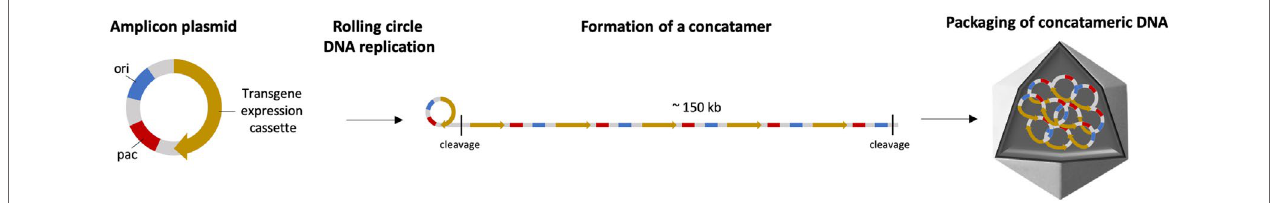
FIGURE 2 | Schematic representation of an amplicon vector. The amplicon plasmid contains the sequences for viral DNA replication (ori, blue) and the packaging signal (pac, red), flanking the transgene expression cassette. In the presence of an HSV-1 helper virus in permissive cells, the amplicon DNA plasmid is replicated as head-to-tail concatemers, cleaved into 150 kb linear DNA and packaged in HSV